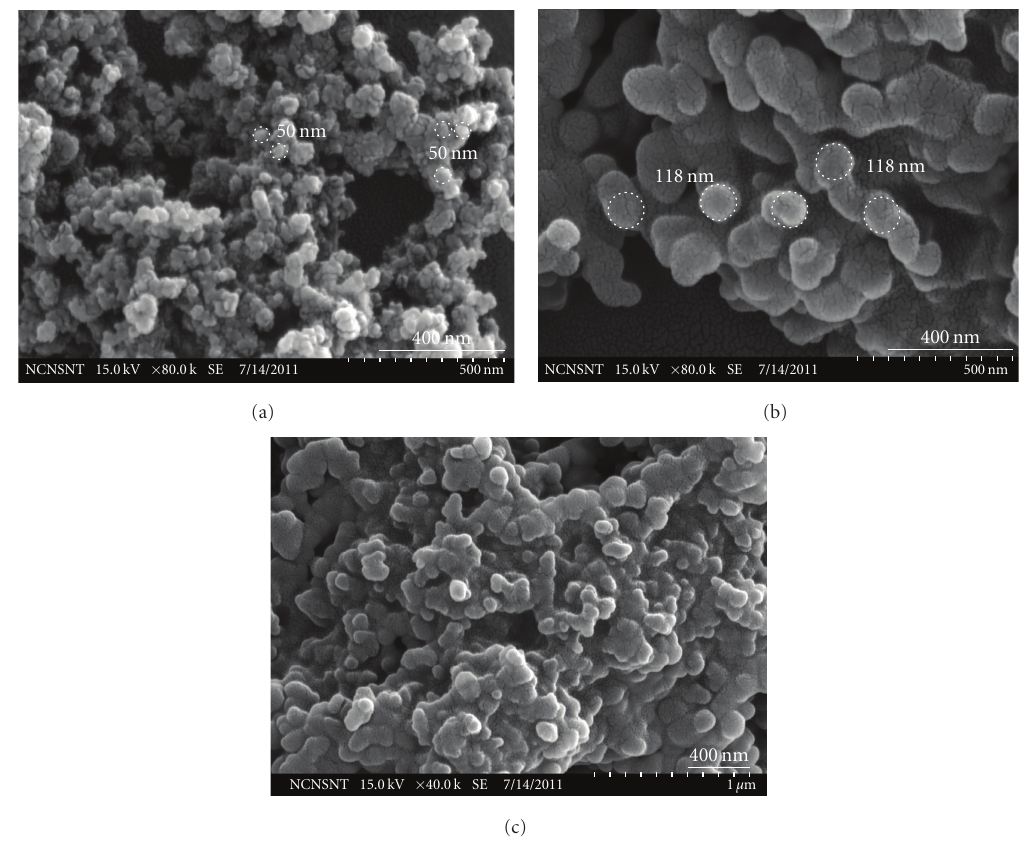
Figure 1: Typical SEM images of GMC (a) and NiHCFe@GMC (b) and